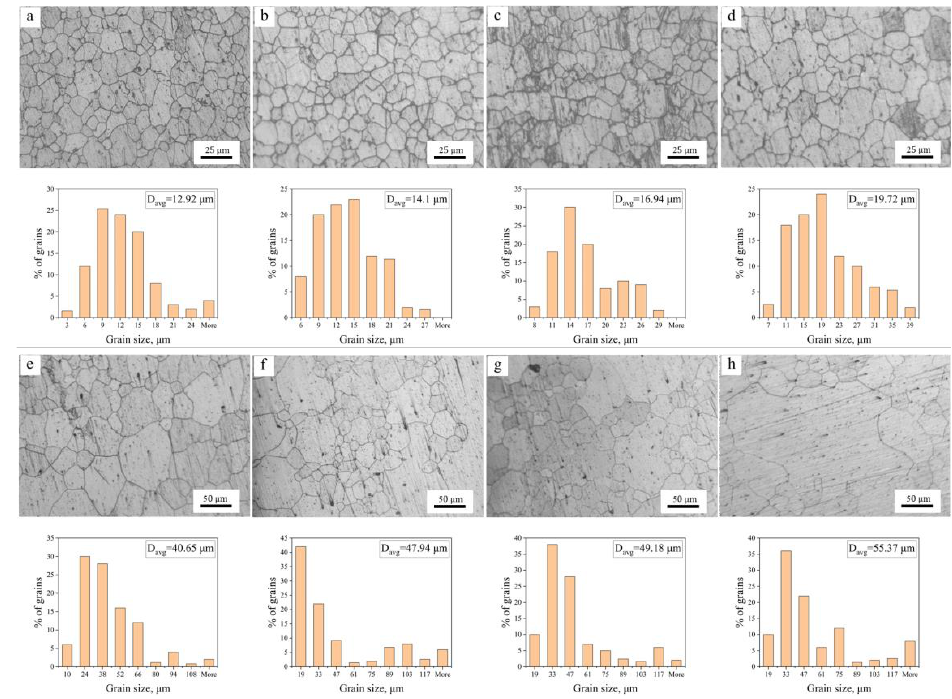
Figure 7. Optical micrographs of ( a – d ) AZ31, ( e – h ) AZ61 annealed at 450 °C for 12, 24, 48, and 72 h. The corresponding histograms of the particle size distribution are shown below each micrograph.